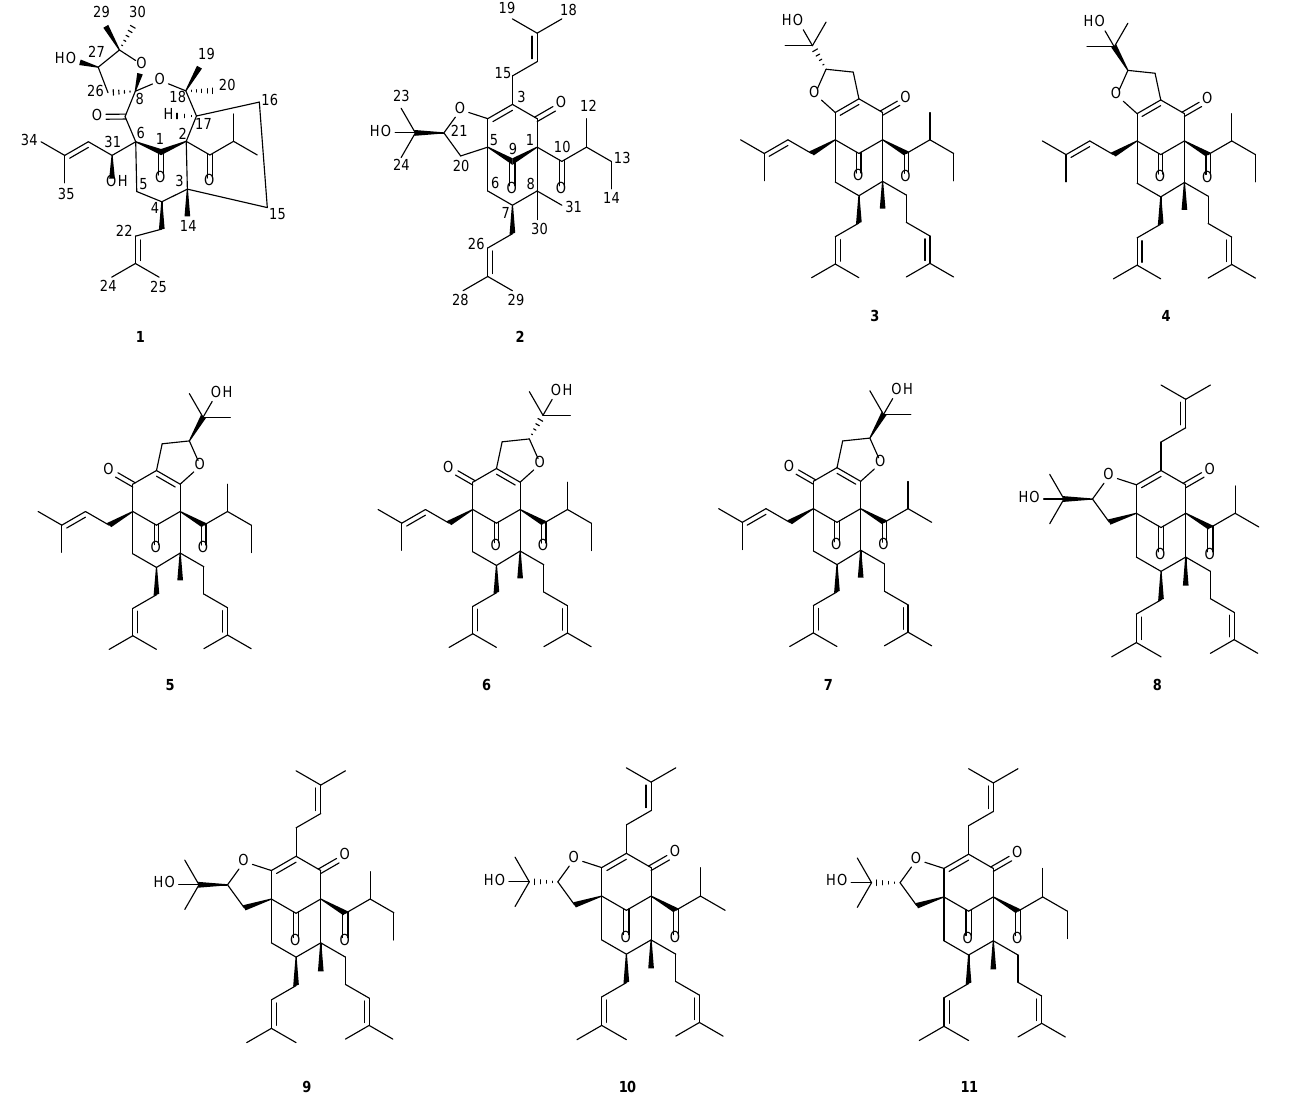
Figure 1. Chemical structures of compounds 1 – 11 .